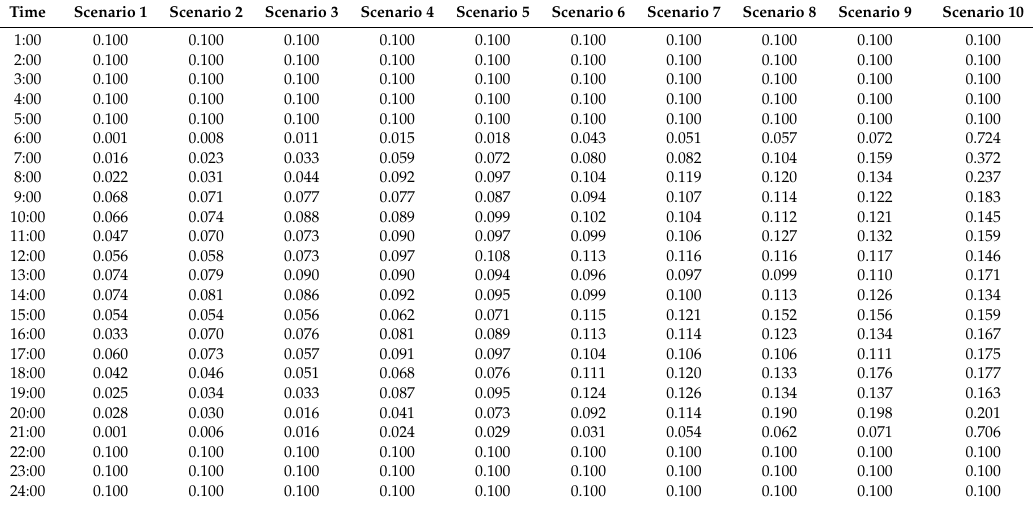
Table 4. Probability at each scenario and